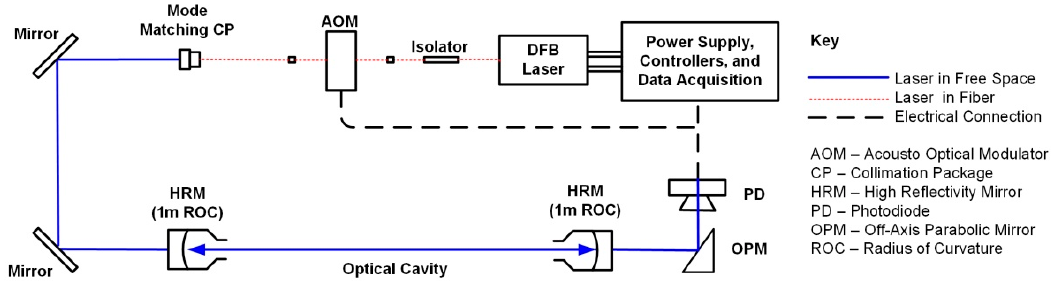
Figure 1. Schematic diagram of CRDS methane sensor.